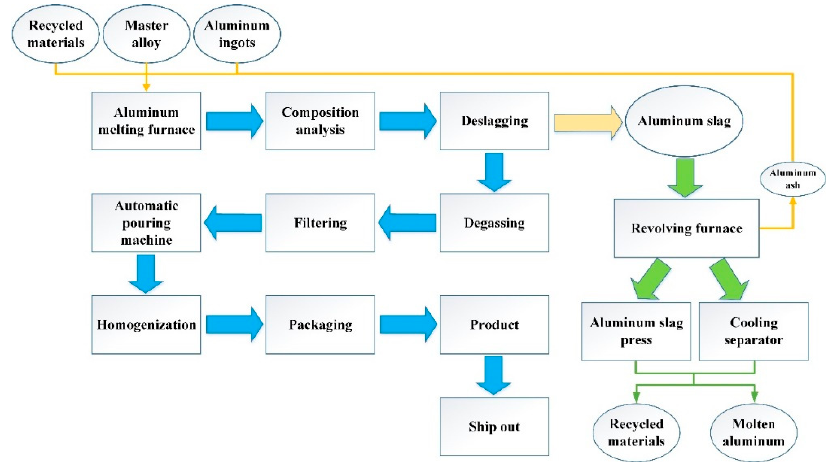
Figure 1. Manufacturing process of aluminum alloys.